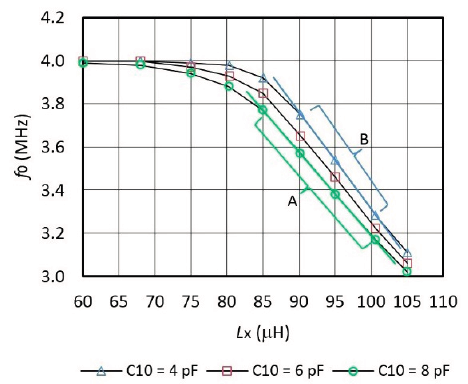
Figure 3. Inductive frequency characteristics f 0 (for different values of capacitance C 10 in parallel to the crystal at T = 25